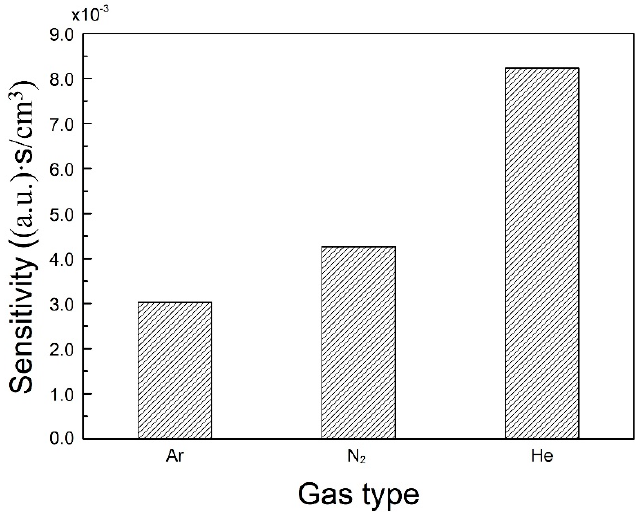
Figure 15. Measurement sensitivity of LIBS signal intensity for Ar, N 2 , and He gases.